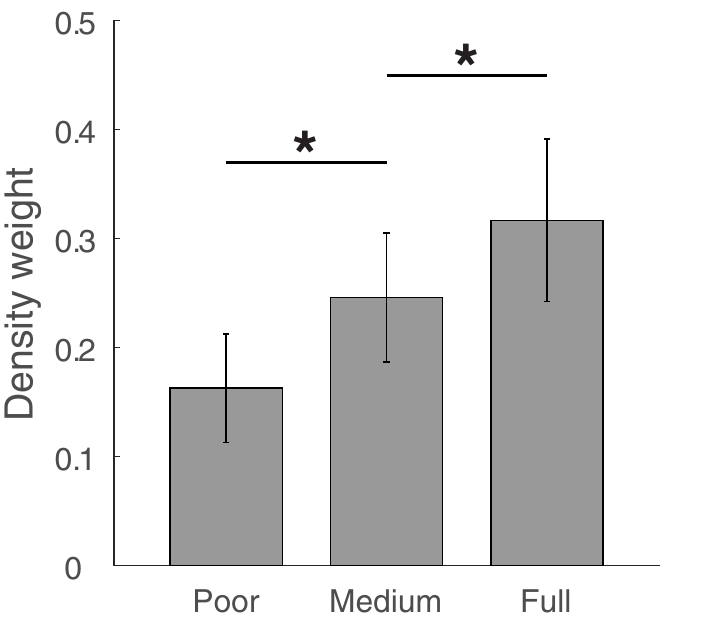
Fig 3. Density weights in Experiment 1. Fitted density weights for the poor, the medium and the full vision condition. Weights are averaged over individual participants with error bars denoting the 95% confidence interval of between- participant variability. (cid:3) p <